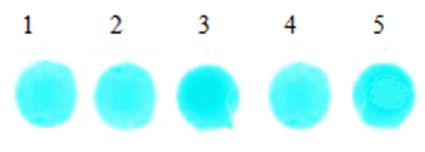
Table 3. Light reflection signal values of dry chemical diagnostic reagents in vitro.